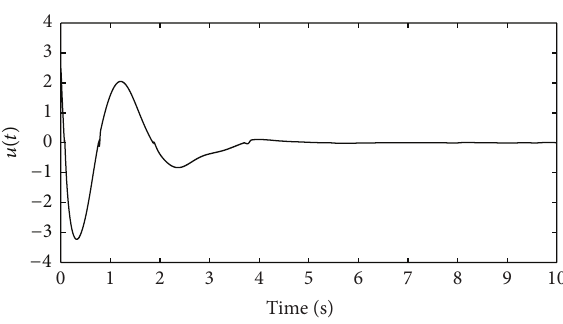
Figure 6: The time response of control input 𝑢(𝑡)